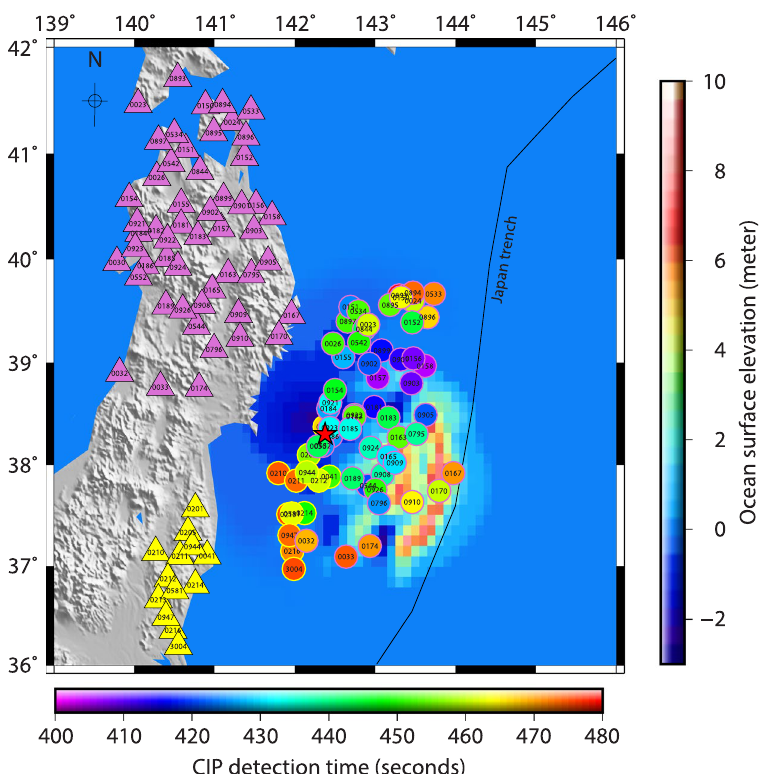
Figure 7. 2D demonstration of the spatio-temporal evolution of CIP projected at their respective detection altitudes estimated in the present study (Supplementary Table 1). The total tsunami water excitation within 60 s of the Tohoku-Oki event is shown in the background for reference. Other information is the same as Fig. 1. Significant corroboration between the spatial evolution of water surface displacement and that of the CIP at their respective detection altitudes could be appreciated. The figure is prepared using the GMT 5.4.1 43